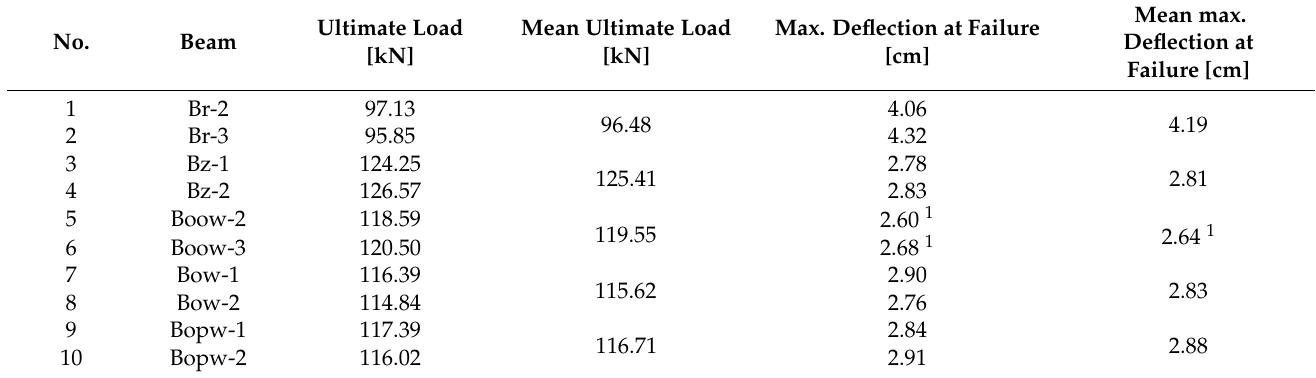
Table 1. Values of ultimate load and maximum deflections during failure for laboratory-tested beams.